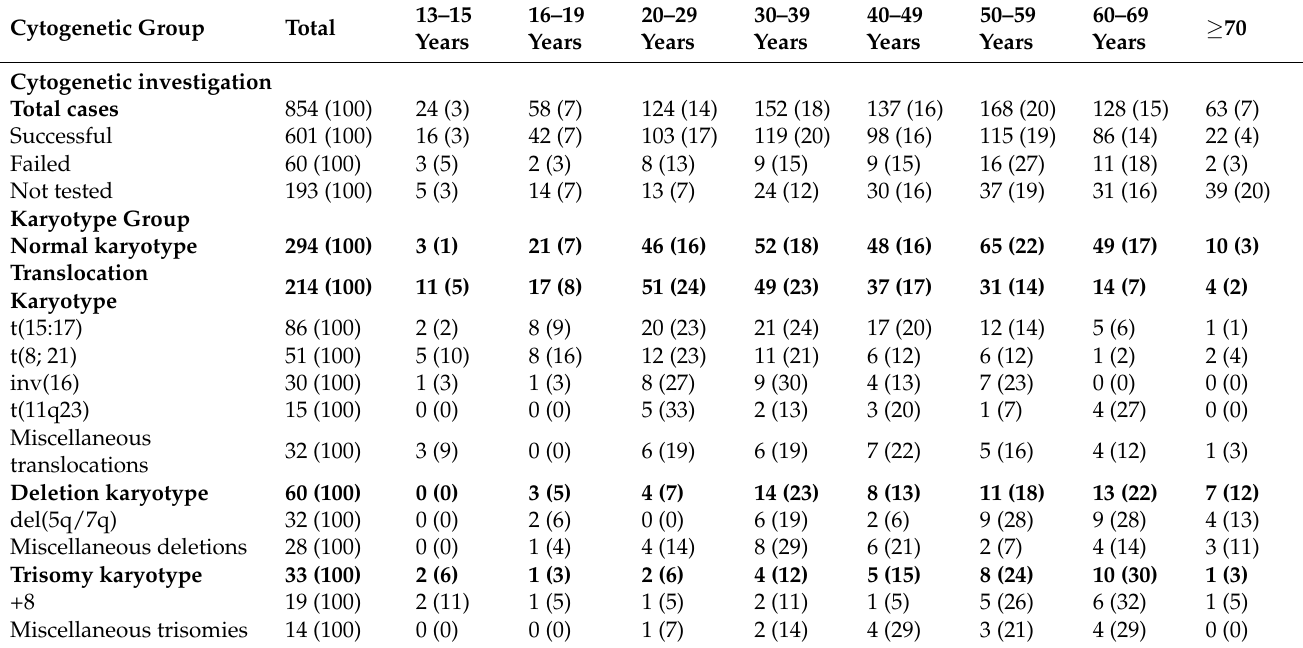
Table 3. Number (%) a of AML patients by age and cytogenetic